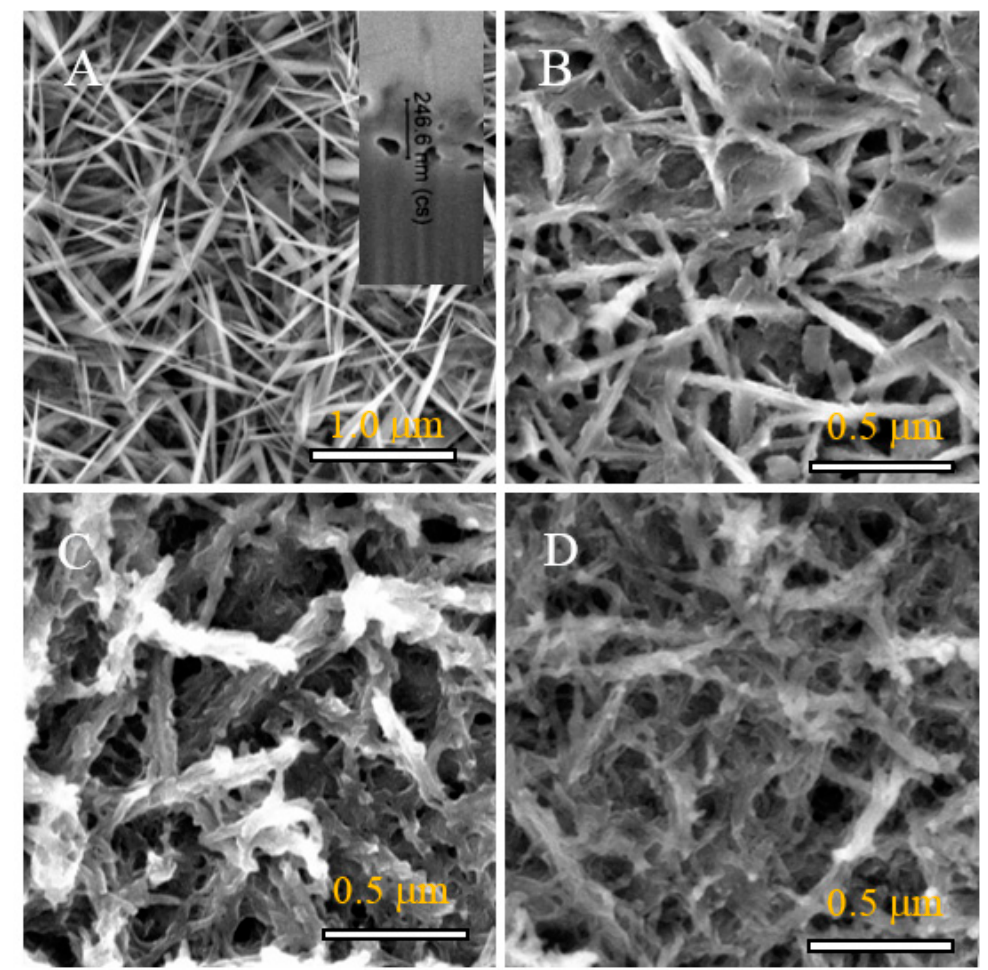
Figure 2. Top-side FESEM images of TiO x film before ( A ) and after ( B – D ) covering with polyaniline by chemical oxidation of aniline with potassium persulfate at 2–4 ° C for 12 ( B ), 24 ( C ), and 48 h. ( D ). The inset shows the film thickness of film grown at 200 ° C for 15 h: pH = 10; 0.3 M SeO 32 − .